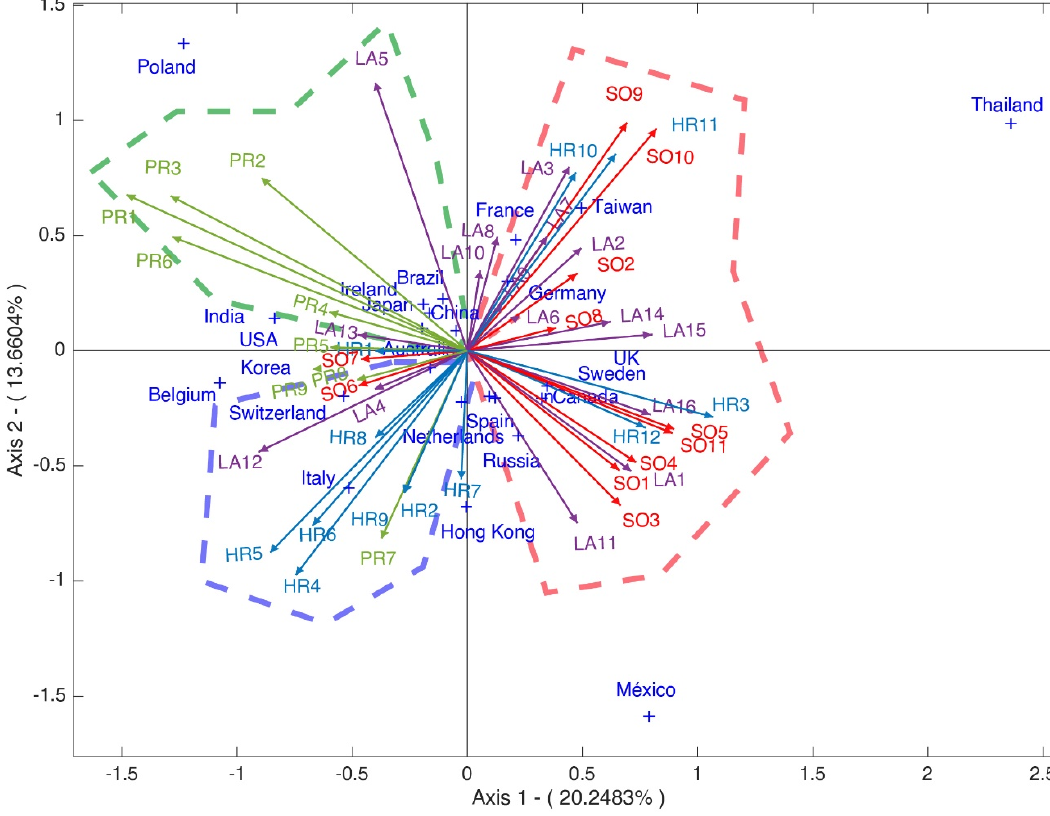
Figure 3. HJ-Biplot Cluster: countries with indicators.